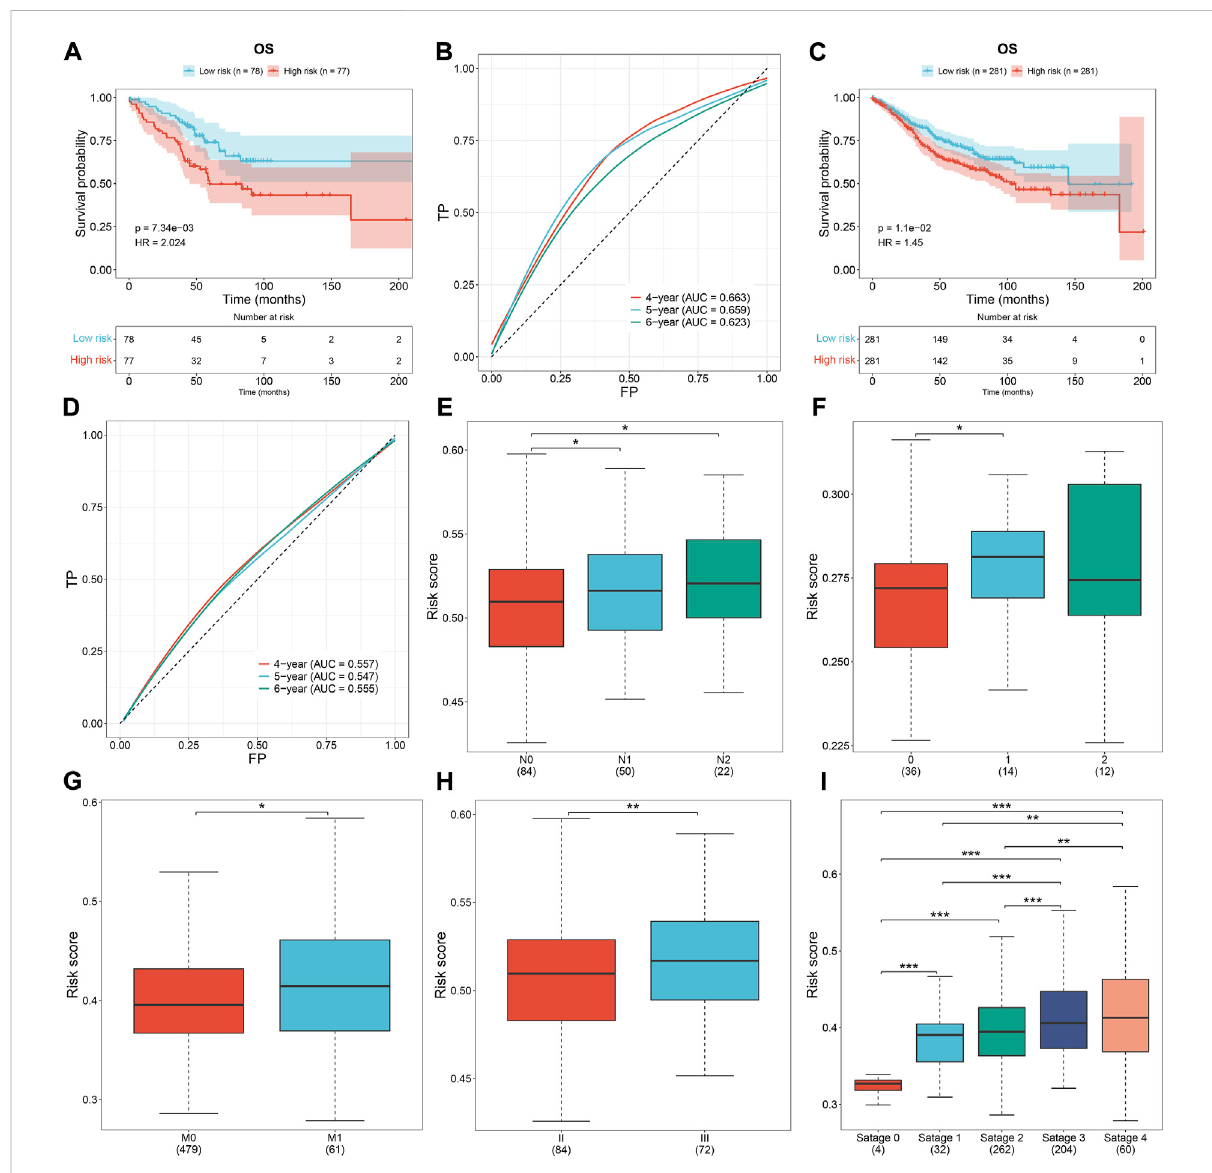
FIGURE 5 External veri fi cation of the oxidative stress-related gene signature. (A,B) Survival analysis and ROCs under 4-, 5-, and 6-year survival in the GSE103479dataset. (C,D) Survival analysisand ROCs under4-, 5-, and 6-year survival in theGSE39582 dataset. (E,F) Risk score across theN stage in the (E) GSE103479 and (F) GSE12945 datasets. (G) Risk score across the M stage from the GSE39582 dataset. (H,I) Risk score across the pathological stage in the GSE103479 and GSE39582 datasets. * p < 0.05; ** p < 0.01; *** p < 0.001. GSE103479: N = 156; GSE39582: N = 562; GSE12945: N =